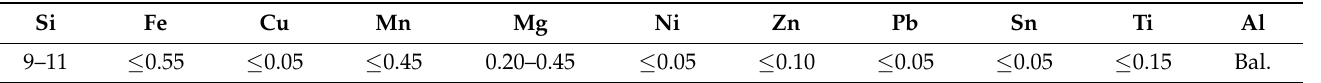
Table 1. Chemical composition of the employed